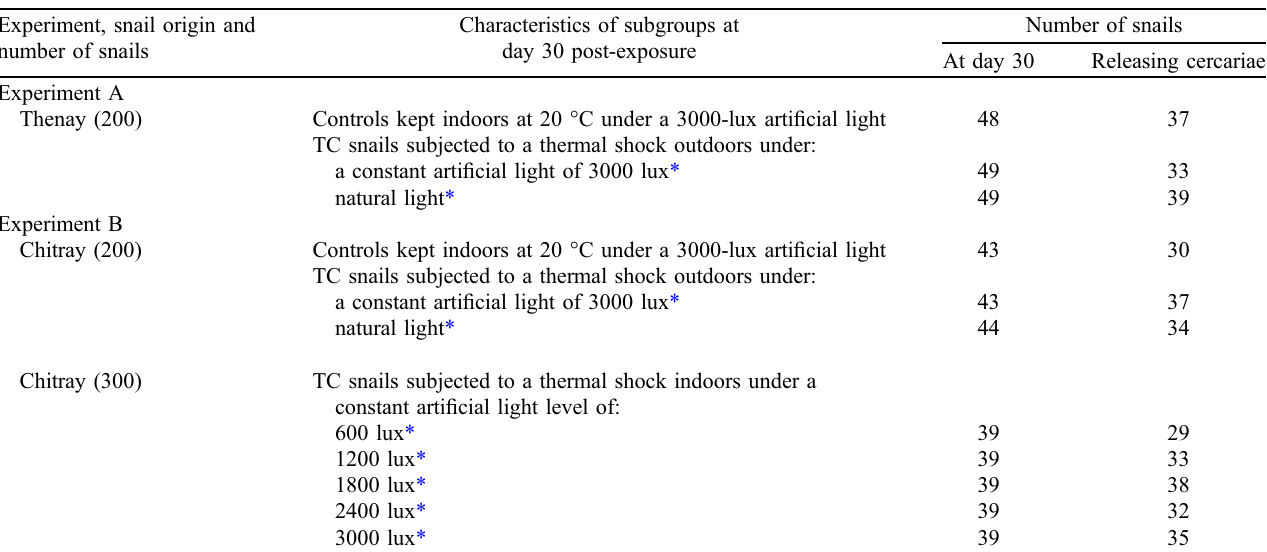
Table 1. Main characteristics of snail subgroups used in the two experiments. To induce thermal shock, Petri dishes containing snails were exposed to a mean of 12 (cid:2) C for 3 h every week. TC: temperature-challenged